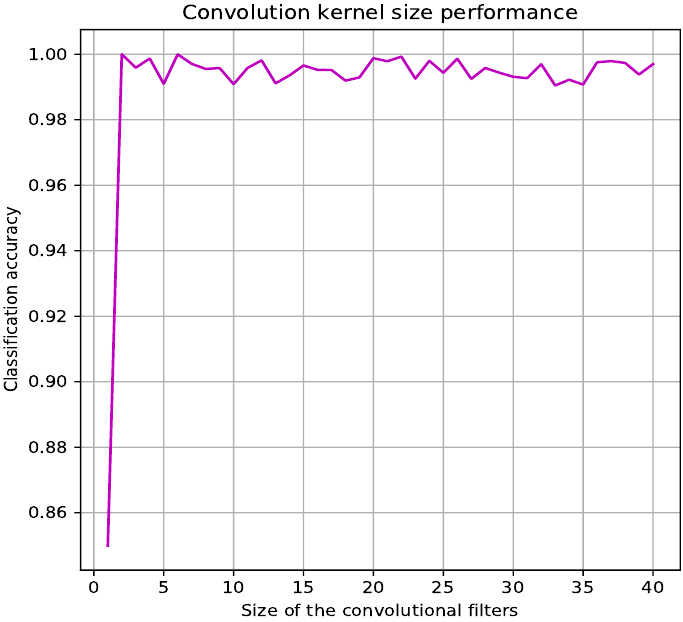
Figure 4. Dependency between the size of the convolutional filters and CNN